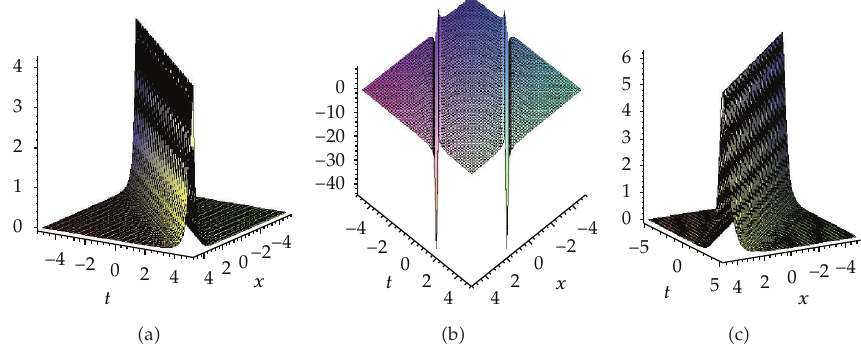
Figure 8: Evolutional behaviour of the intensity | u 1 | 2 describes the bright soliton: (cid:3) a (cid:4) p (cid:7) 1 ,q (cid:7) 1; (cid:3) b (cid:4) p (cid:7) 1 / 332 ,q (cid:7) 1 / 333 (cid:3) singular wave solution (cid:4) ; (cid:3) c (cid:4) p (cid:7) 2 . 132 ,q (cid:7) 1 .